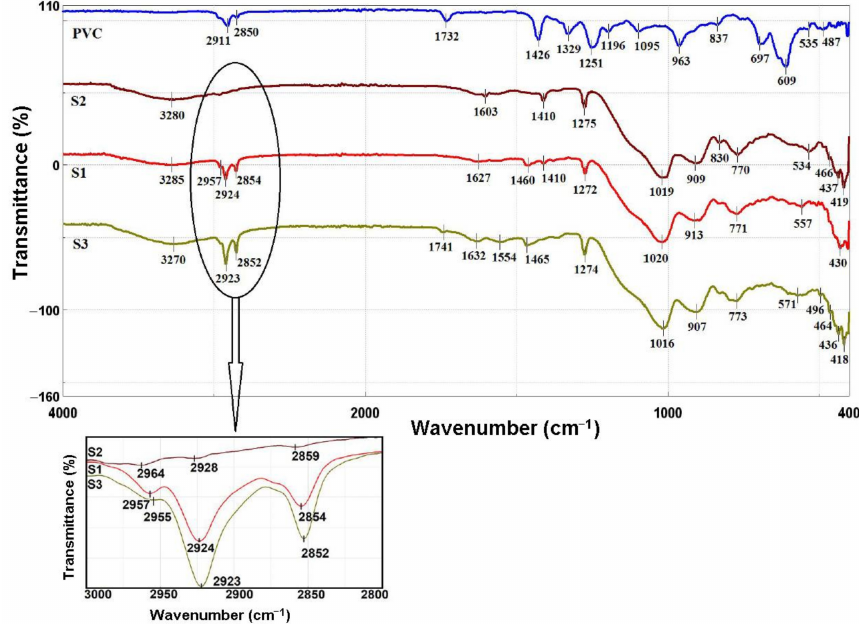
Figure 1. FTIR spectra of the sol-gel silica materials deposited on PVC